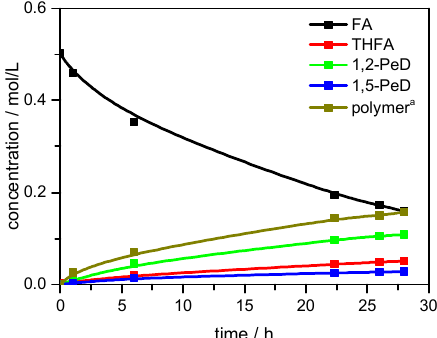
Figure 1. Temporal evolution of the concentrations during 28 h reaction time. (Reaction conditions: 1 g catalyst 9, 150 mL of 5 wt. % FA in H 2 O; 300 mg Na 2 CO 3 ; pH 2 = 5 MPa, T = 443 K) a amount of polymer is calculated from the mass balance of the gas chromatographic